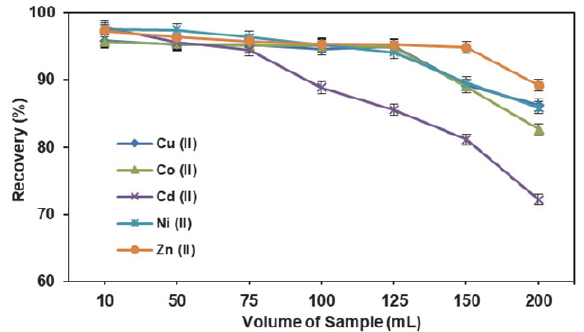
Figure 3. Effect of sample volume on the recovery of the analytes (Eluent vol.:1.0 mL, n = 3)